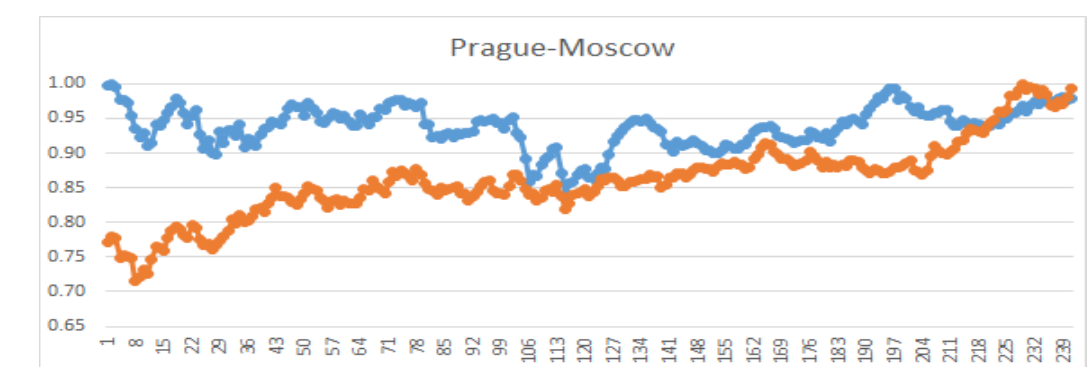
Figure 3. Comparison of graphs of normalized prices for Prague and Moscow; S ( Prague,Moscow ) = 0.77.